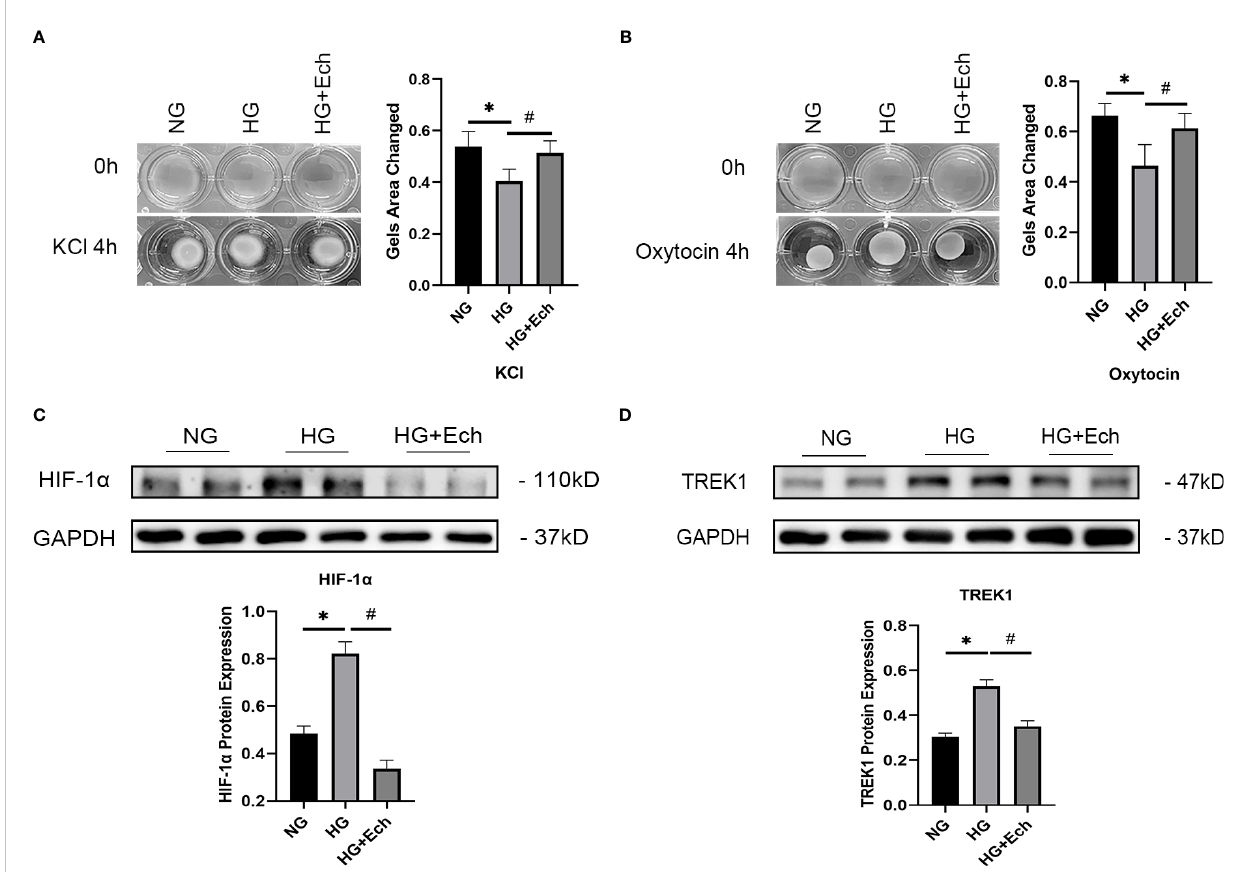
FIGURE 5 Hypoxia inhibition recovered the decreased cell contractility under high glucose levels. We divided HUSMCs into the normal glucose (NG, 5.5 mmol/ L) group, the high glucose (HG, 25 mmol/L) group, and the high glucose with echinomycin (HG+Ech) group to inhibit hypoxia in a 24-well culture plate. The medium was added after collagen polymerization (0 h). The images of collagen stimulated by KCl (A) or oxytocin (B) for 4 h. The contraction of HUSMCs was assessed by measuring the mean gel area change. The HUSMCs of each group were cultured in NG medium at the beginning. Then, the NG medium in the HG and HG + Ech groups was replaced with HG medium for 24 h when the cell density reached 60% – 70%, after which echinomycin was added to the HG + Ech group for 4 h. The total protein of each group was then extracted, and HIF-1 a (C) and TREK1 (D) protein expression was measured by western blot analysis. Data are presented as means ± SEM, n = 4 for each group. * means HG vs. NG and P<0.05. # means HG+Ech vs. HG and P<0.05. HIF-1 a , hypoxia-inducible factor-1 alpha; HUSMCs, human uterine smooth muscle cells; SEM, standard error of the mean; TREK1, TWIK-1-related potassium